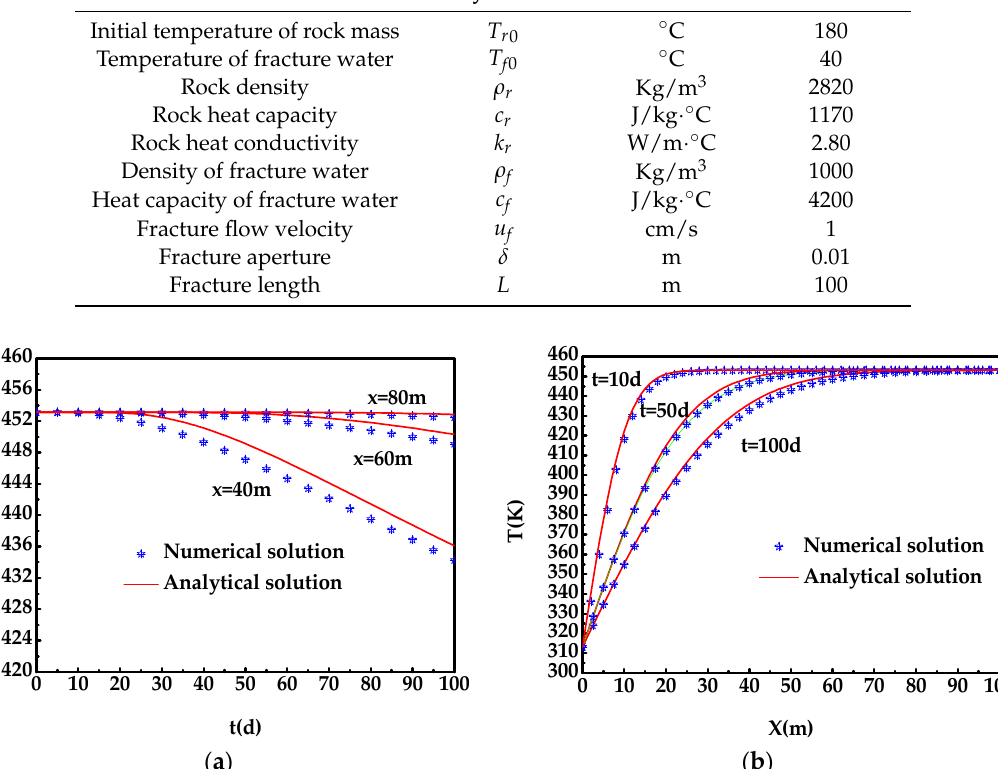
Figure 3. Comparison of numerical and analytical solutions for two-dimensional single-fracture model. ( a ) Temperature variation with time at different locations in the fracture; ( b ) Temperature variation with position at different times in the fracture.